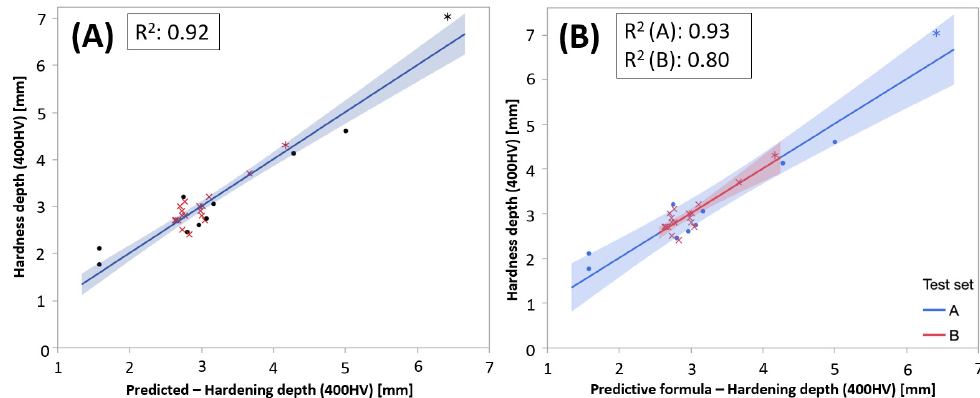
Figure 17. Actual by predicted using the third minimal model based on only BN-parameters.